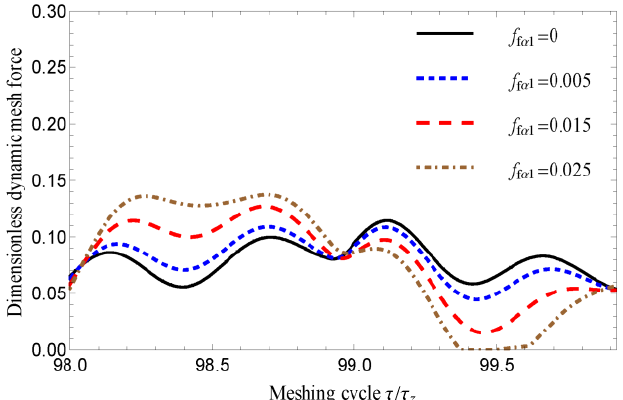
Figure 12. Dynamic mesh force of a single pair of teeth under different 𝑓 𝑓𝛼1 .